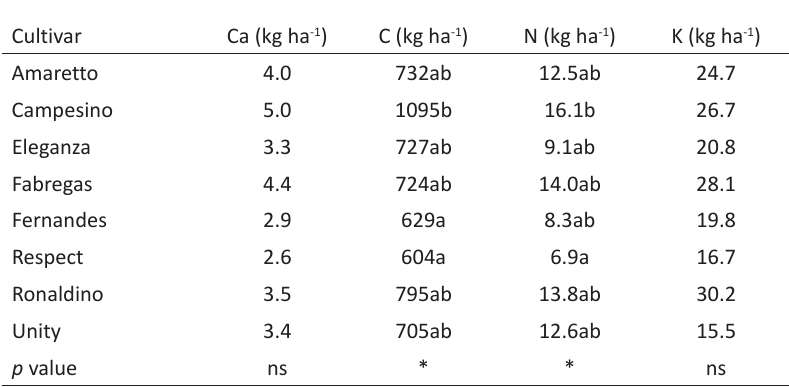
Table 5. The amount of Calcium (Ca), Carbon (C), Nitrogen (N) and Potassium (K) in lower stalk of eight maize cultivars in 2010 and 2011. Data shown are means, n = 8 Cultivar Ca (kg ha -1 ) C (kg ha -1 ) N (kg ha -1